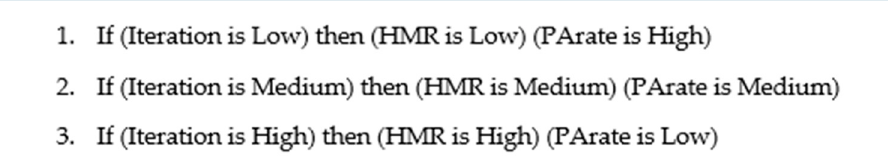
Figure 13. Rules for Fuzzy System 3 to Decrease (FHS3).